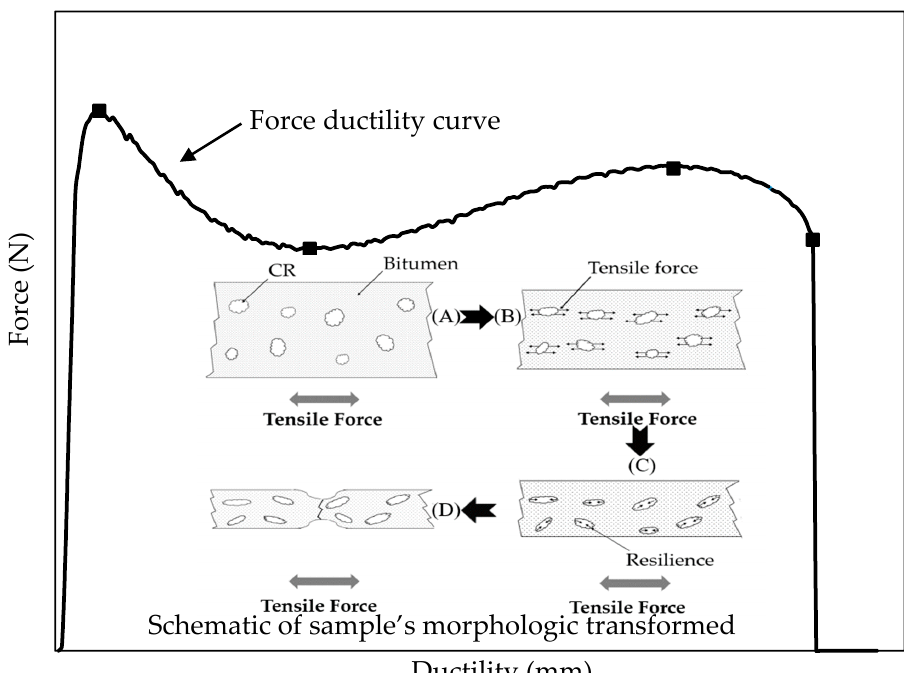
Figure 6. The force–ductility curve of rubberized bitumen.